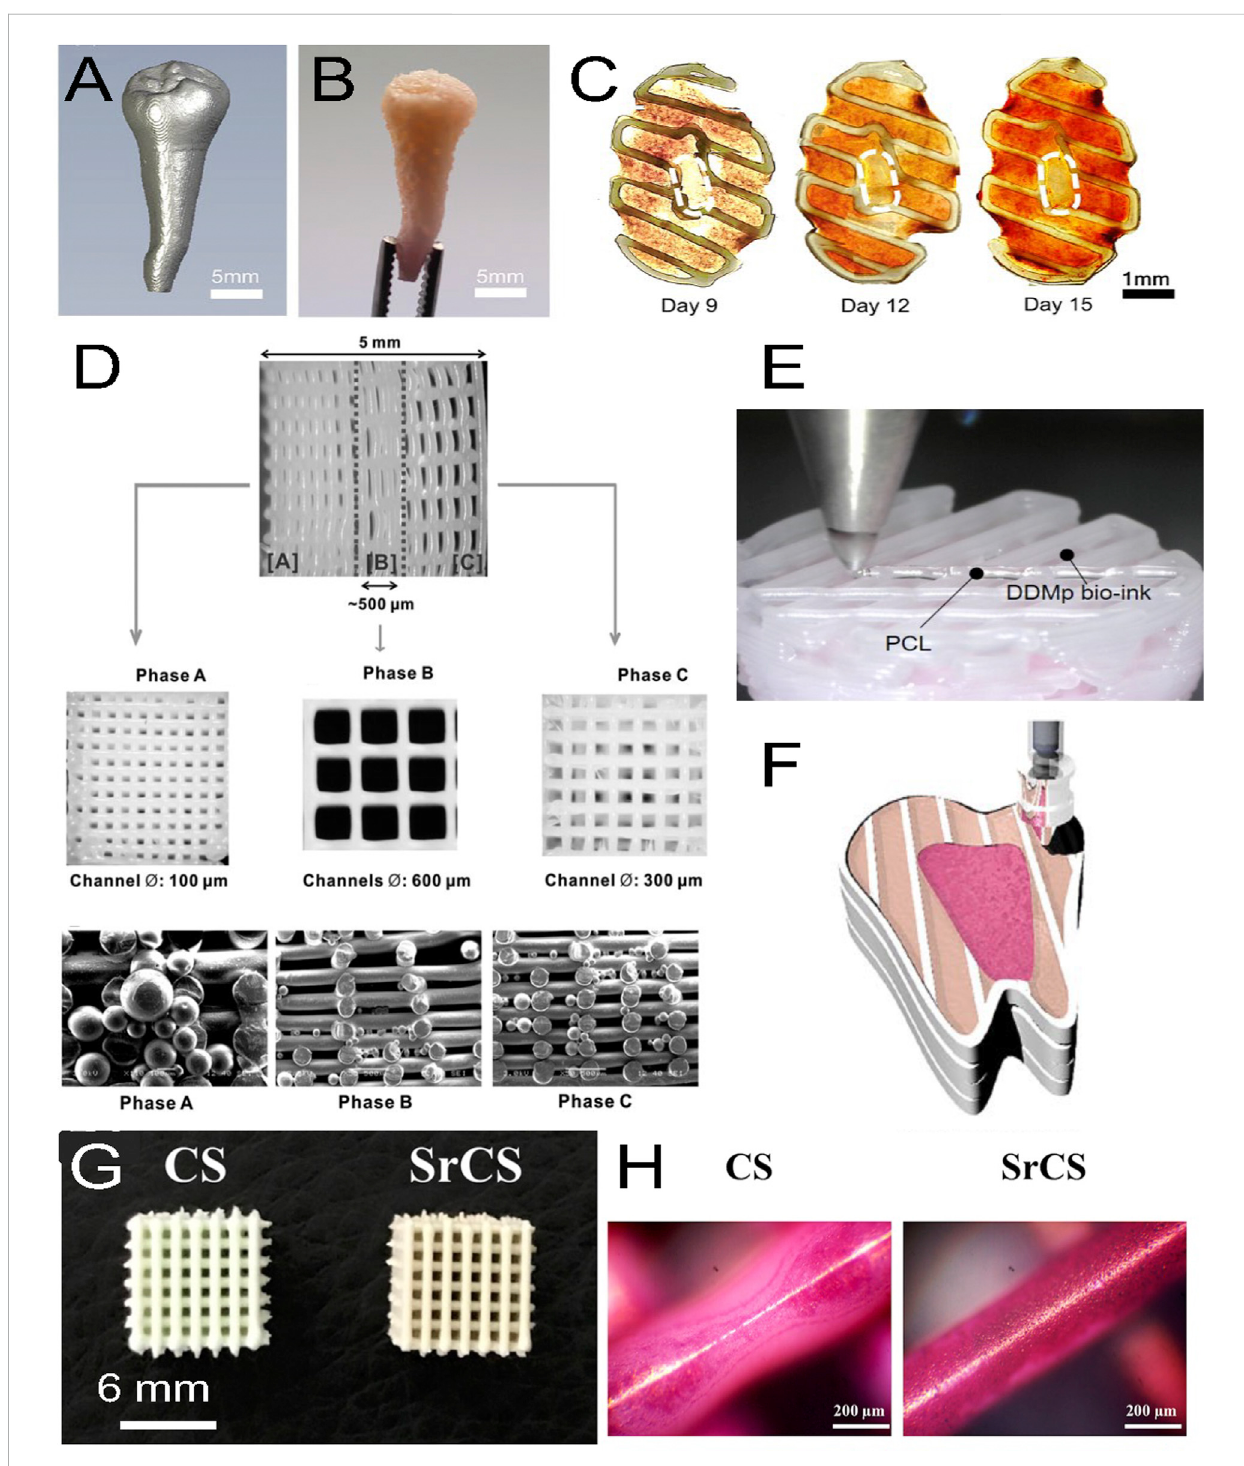
FIGURE 3 (A) Micro-CT image of a patient tooth, (B) with its 3D printed model with a fi brinogen-gelatin-hyaluronic acid-glycerol bioink loaded with hDPSCs. (C) Cross-sectional viewsoftheconstruct stainedwithalizarinredSatdifferentdaysofculture. Thestainingshows aspatial depositionofcalcium,which corresponds to a spatial differentiation of hDPSCs that mimics the dental pulp complex, with an unmineralized central area (white dashed circles) similar to a pulp center and a mineralized outer area similar to a dentin region. (D) 3D printed triphasic scaffold of PCL-hydroxyapatite (HA) bioink used for PDL regeneration. Phase (A) A scaffold area with 100 μ m microchannels and PLGA microspheres loaded with amelogenin was seeded with hDPSCs for dentin-cementum formation. Phase (B) A scaffold area with 600 μ m microchannels and PLGA microspheres loaded with CTGF was seeded with hPDLSCs for periodontal ligament formation. Phase (C) A scaffold area with 300 μ m microchannels and PLGA microspheres loaded with BMP-2 was seeded with hABSCs for alveolar bone formation. (E) Multimaterial bioprinting of a construct with a PCL bioink and a fi brinogen/gelatin/hyaluronic acid/ glycerol/human demineralized dentin matrix (DDM 10%) bioink with hDPSCs for odontogenic differentiation. (F) Schematic showing the bioprinting